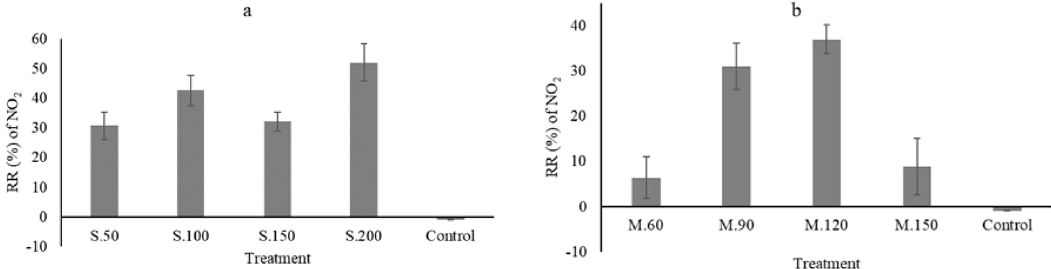
Fig. 9. The removal rates, averages and error bars of the four replications, of NO 3 (%) in the control and at various densities of both G. verucosa (a) and P. viridis